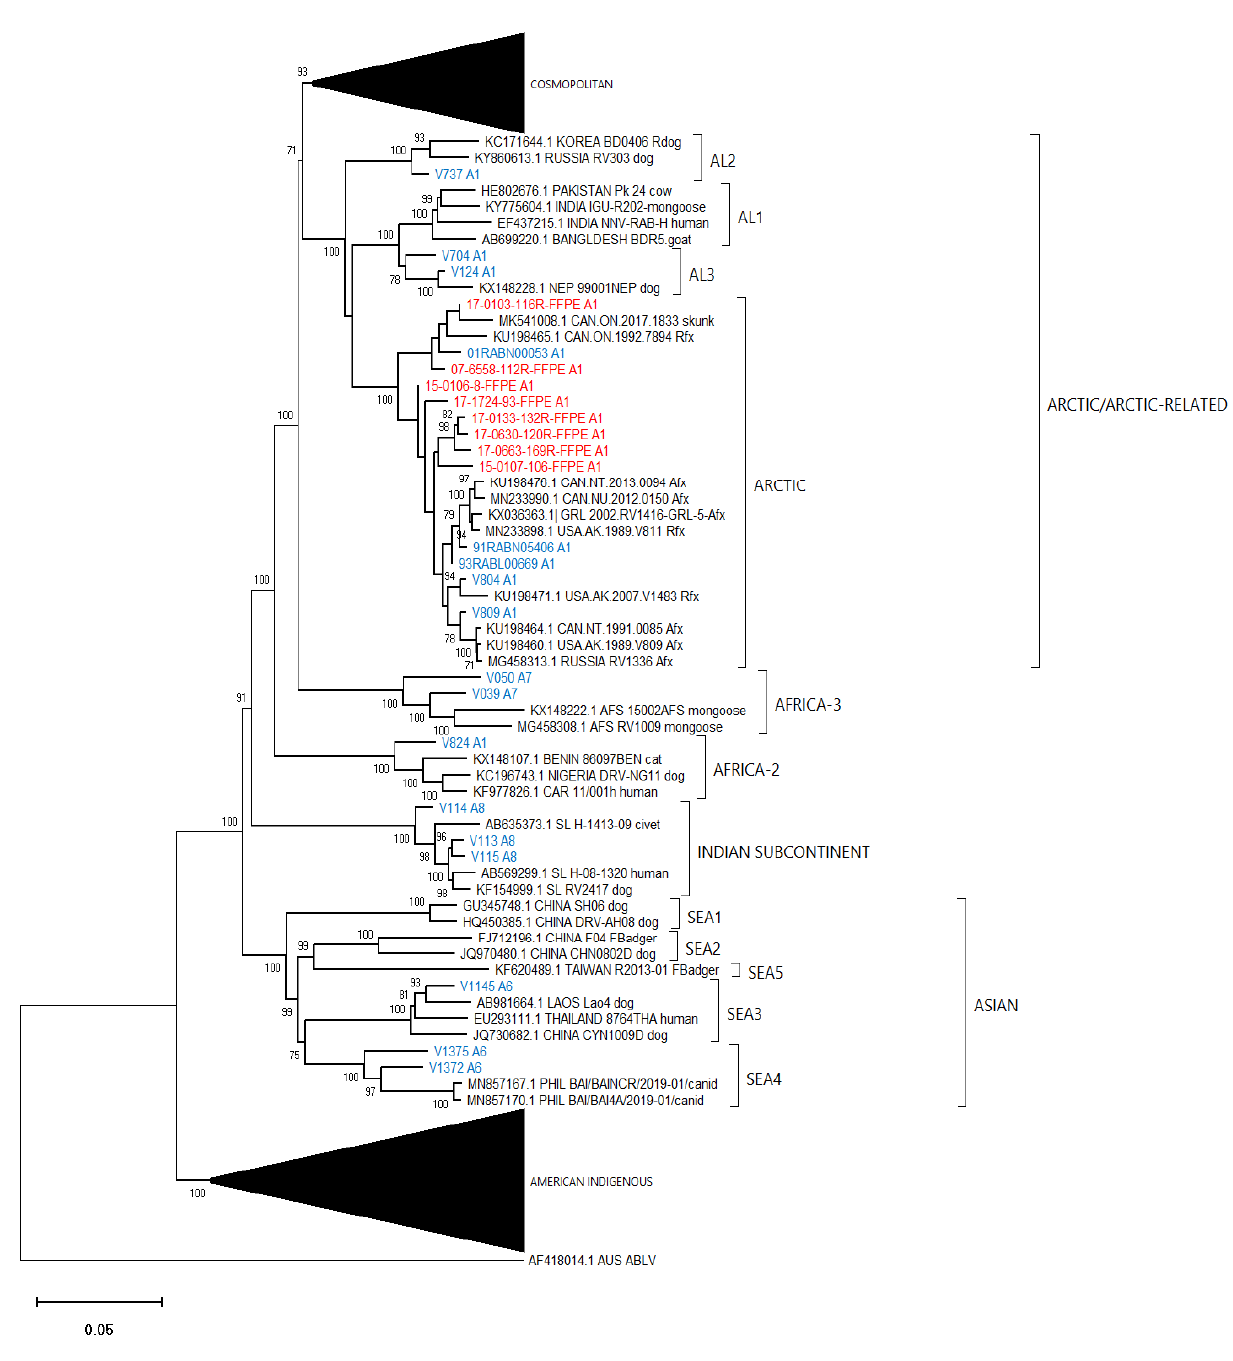
Figure 7. Neighbor joining tree of 86 RABV test samples and 100 representative RABV genomes showing details of the Arctic and Arctic-related, Africa-2, Africa-3, Asian and Indian Subcontinent lineages. Sample genomes were reconstructed through reference-guided assembly of the Ampliseq reads using eight different references as indicated by the A1 to A8 suffix following the taxon name. Sequences generated from unfixed samples are shown in blue while those from FFPE samples are in red. Numbers at nodes indicate bootstrap values ≥ 70%. Lineages and variants are identified to the right of the tree.